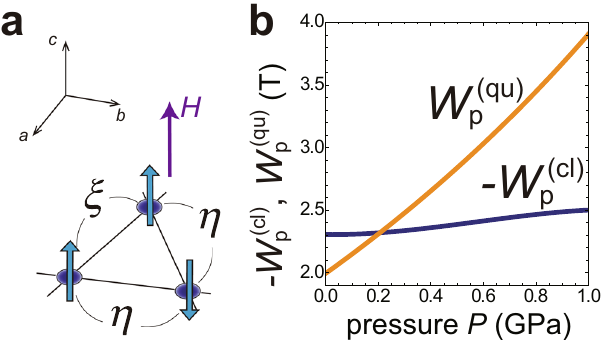
Fig. 8 Two contributions to the plateau width. a Quantum fl uctuation measures η and ξ in the UUD state. b Classical and quantum contributions, W ð cl Þ and W ð qu Þ , to the plateau width as functions of pressure P . We plot p p W ð cl Þ with the negative sign for p